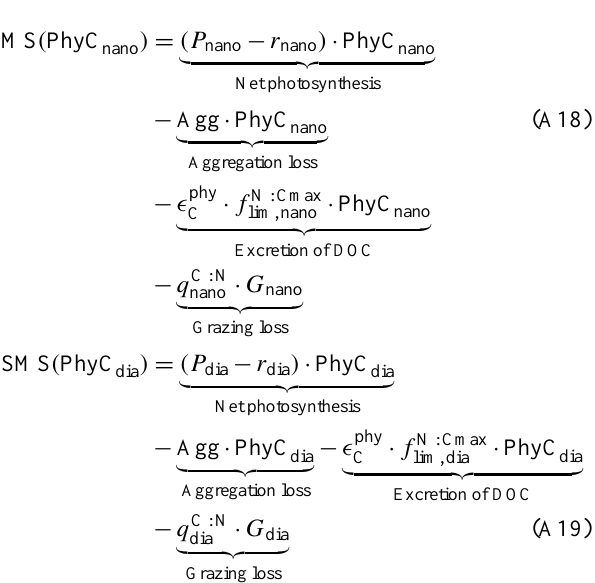
Table A3. When the N : C ratio becomes too high, excretion of DOC is downregulated by the limiter function ( f N:Cmax described in Sect. A6.1. A further loss term is phytoplankton aggregation (Agg), which transfers N to the detritus pools (Eq. A27). The grazing loss ( G nano and G dia ) is calculated in Eqs. (A52) and (A53), respectively.